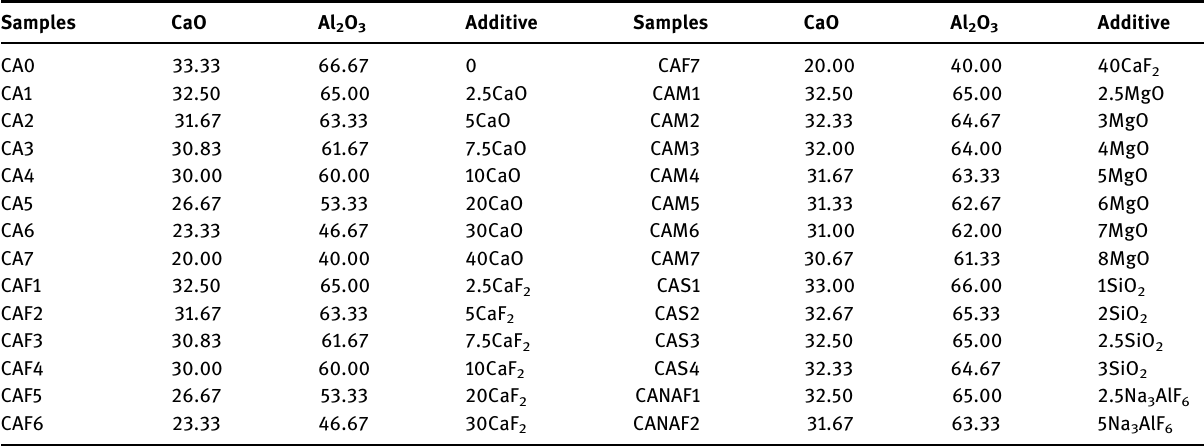
Table 1: Composition of slag samples ( mass % )